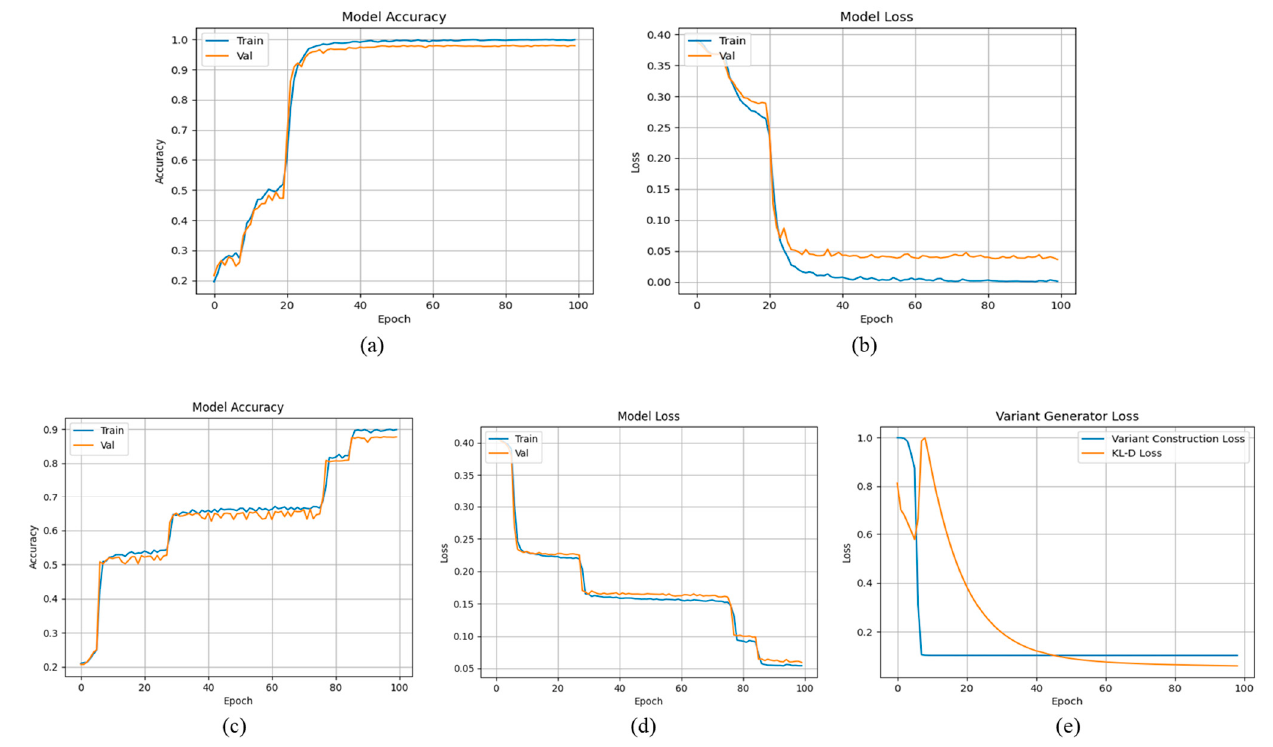
Figure 4. The training and validation performance recoded during training epochs: ( a ) accuracy for nucleotides, ( b ) loss for nucleotides, ( c ) accuracy for protein, ( d ) loss for protein sequence data, and ( e ) shows the new variant construction loss.